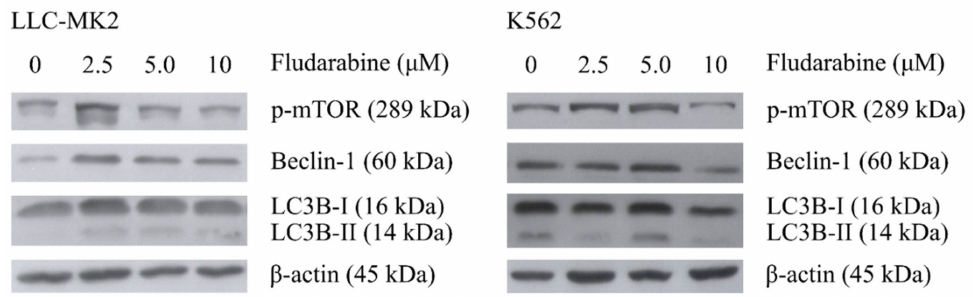
Figure 2. Western blot analysis of protein expression in LLC-MK2 and K562 cell treatment with Fdb (concentrations 0, 2.5, 5, 10 µ M) for 24 h. The total cellular proteins were extracted and transferred to nitrocellulose membranes. The membranes were immunostained with specific antibodies against the autophagy-related proteins p-mTOR, Beclin-1, and LC3B-I/LC3B-II and processed for reaction color development. β -Actin was used as an internal control.